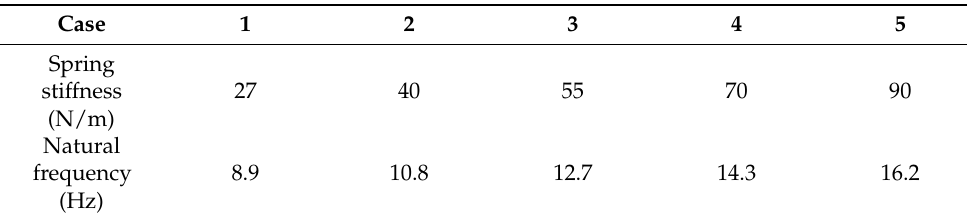
Table 2. Spring stiffness and natural frequency of five different cases used